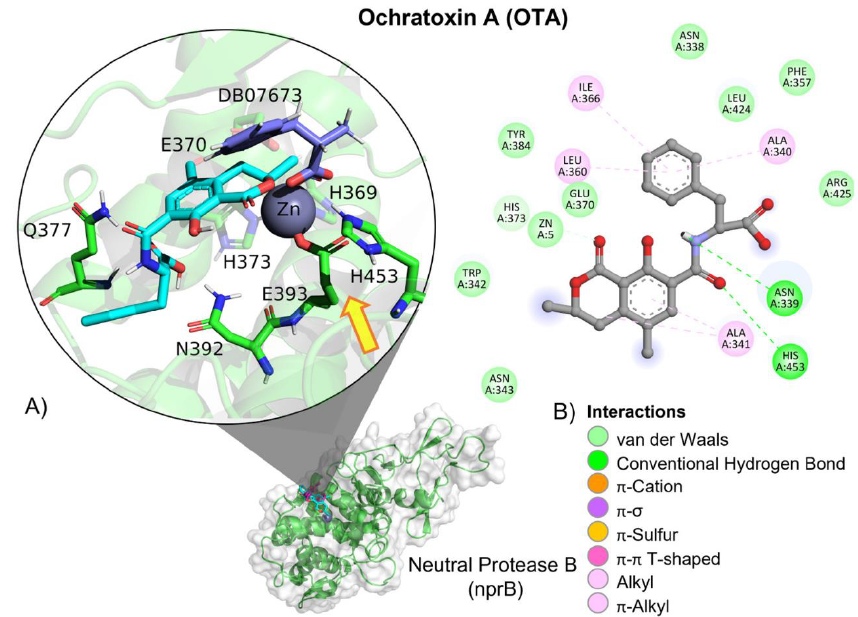
Figure 20. Ochratoxin (OTA) — neutral metalloendopeptidase interactions. ( A ) Panoramic view of the reference (DB07673) and the tested OTA ligands within a neutral metalloendopeptidase binding site, showing the docked poses of the tested and reference ligands. ( B ) Detailed view showing the interactions of the different amino acid residues within the binding site of neutral metalloendopep- tidase with the OTA ligand. The yellow arrow shows the proximity between the neutral protease B catalytic triad and the OTA amide bond, suggesting its breakup. The inactivation mechanism in OTA by neutral metalloendopeptidase triggers the catalytic action of the Zn that attacks the carbonyl of the amide group in OTA, resulting in α -ochratoxin and β -phenylalanine as final products (Figure 21).